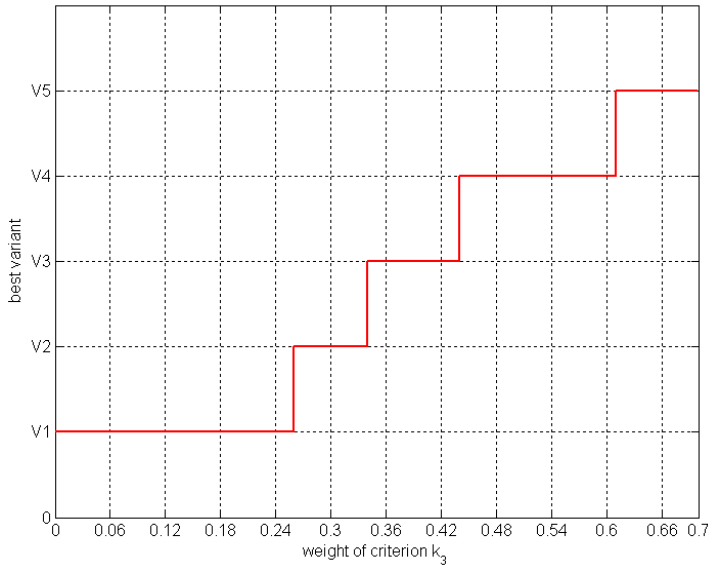
Figure 14. Influence of the weighting of criterion k 3 on the result of multi-variant analysis—own study.